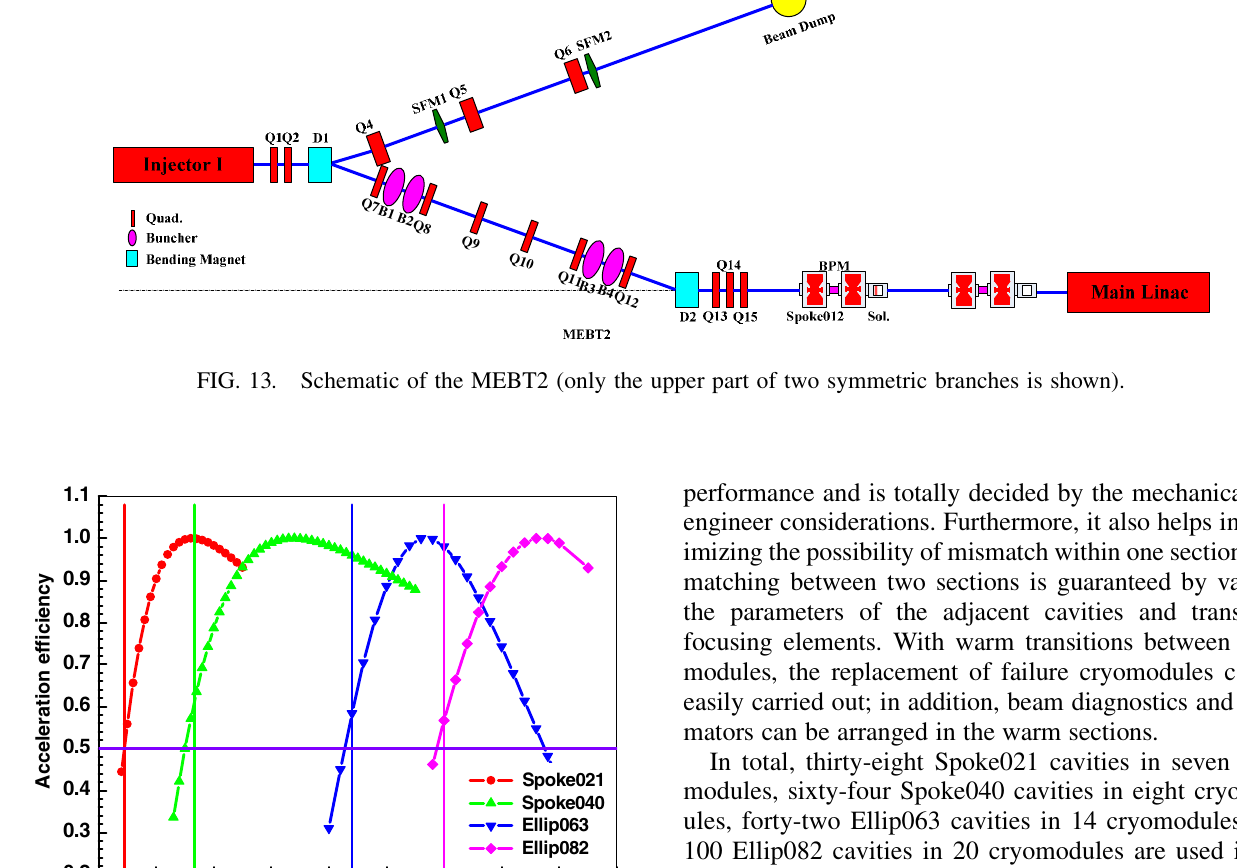
0.1 FIG. 14. Acceleration efficiency curves of the SC cavities in the main linac.